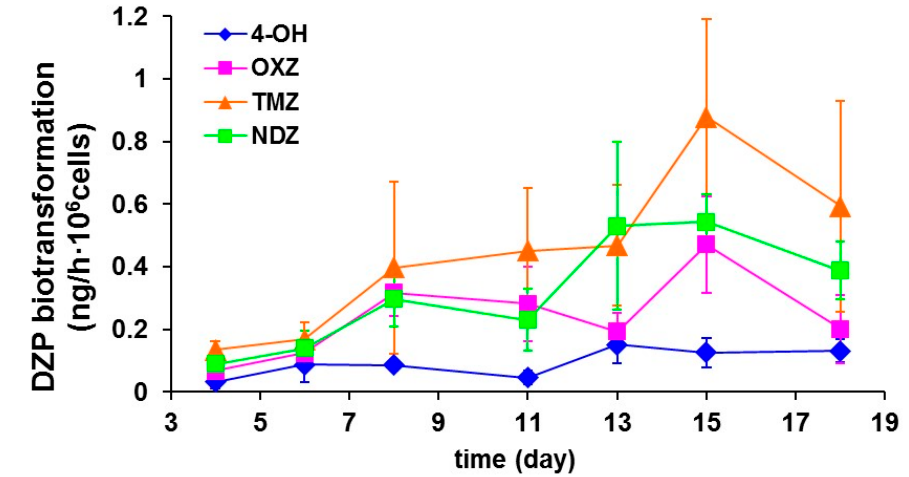
Figure 8. Diazepam biotransformation by primary human hepatocytes cultured in the PCL HF membrane bioreactor with human endothelial cells: temazepam (TMZ), nordiazepam (NDZ), 4-hydroxydiazepam (4-OH) and oxazepam (OXZ). The values are the mean ± standard deviations of three experiments.